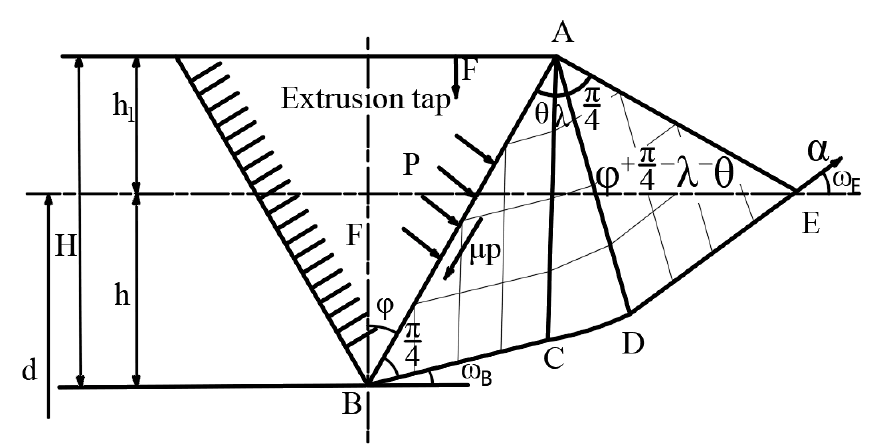
Figure 3. The slip line field of a single extruded tapered tooth pressed into the magnesium alloy material.